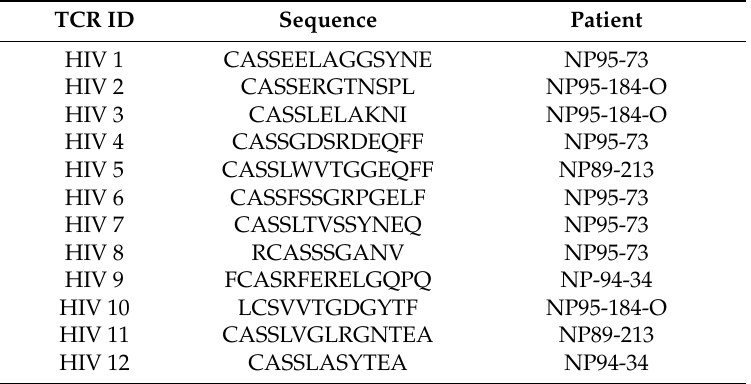
Table 5. List of TCR sequences from HIV patients synthesized for use in ELISA experiments (randomly selected from Lin et al., 2005 [58]).